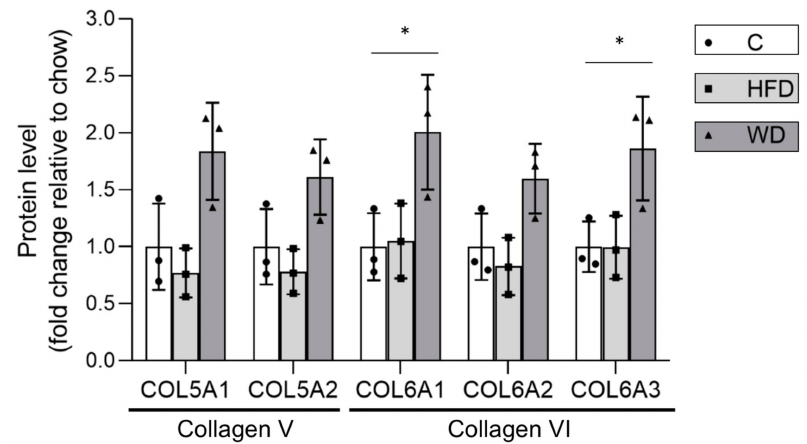
Figure 2. Altered levels of COL5A1, COL5A2 (Collagen Type V Alpha 1 and 2 chains), COL6A1, COL6A2, and COL6A3 (Collagen Type VI Alpha 1, 2 and 3 chains) in steatotic livers of mice fed with standard chow, HFD, and WD. The levels of several collagens are seen to be significantly altered in steatotic livers of mice fed with Western diet, suggesting increased fibrosis. Changes are shown relative to levels in chow-fed mice. Bars indicate mean ± standard deviation for n = 3 mice; individual data points are shown for each mouse fed chow diet (circles, white bars), HFD (squares light grey bars), and WD (triangles, dark grey bars). * p < 0.05 as determined by unpaired student t-test versus chow diet.